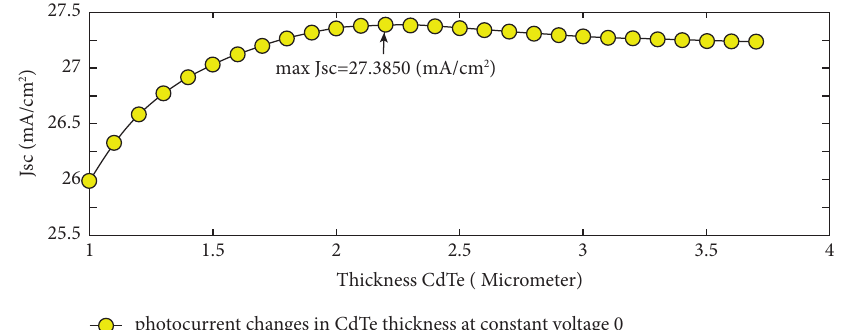
Figure 15: Short-circuit current in terms of the thickness of the absorber layer at a constant voltage of zero v.